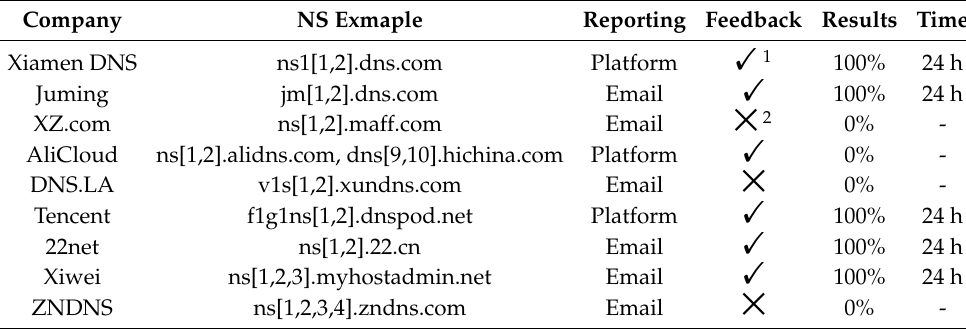
Table 6. Overview of DNS Hosting